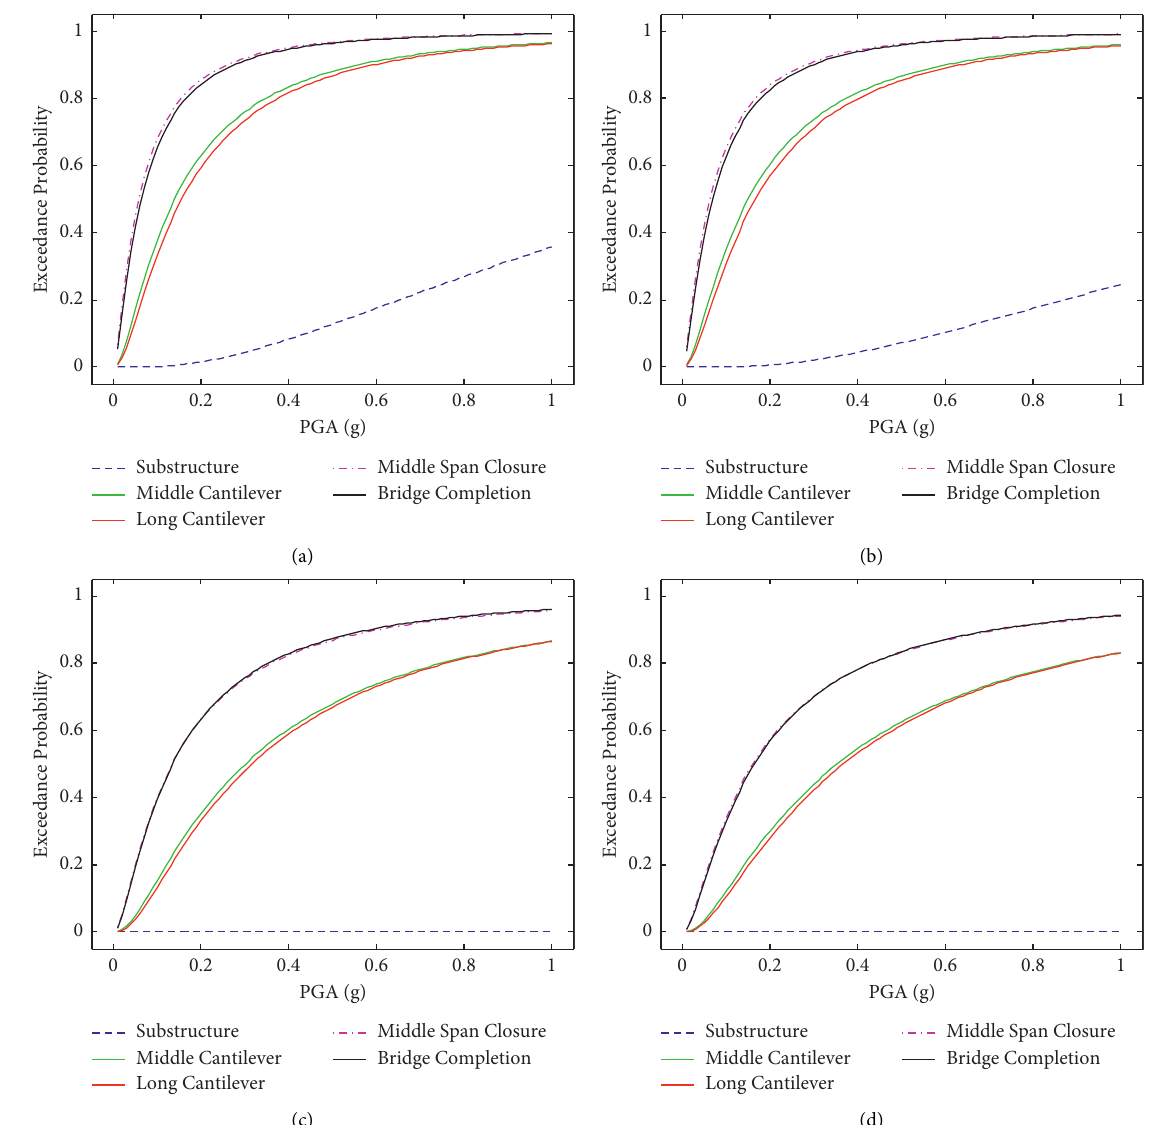
Figure 7: Fragility curves of different damage states. Exceedance probability of (a) slight damage state, (b) moderate damage state, (c) extensive damage state, and (d) collapse damage